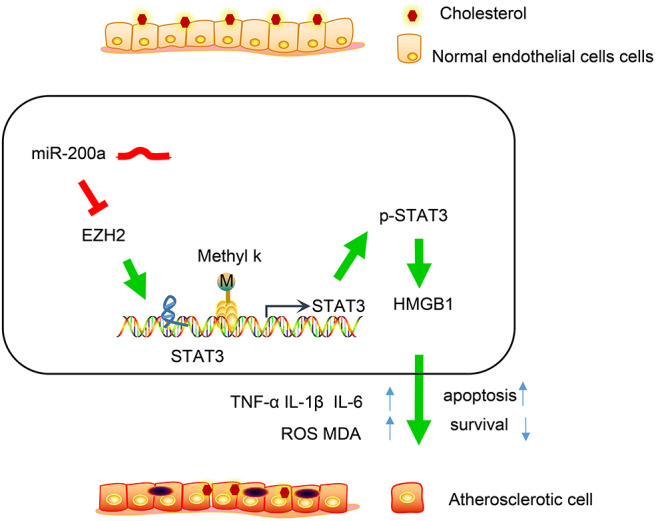
Schematic representation of the regulatory mechanism of miR-200a involvement in atherosclerosis. Overexpression of miR-200a inhibits EZH2 and HMGB1 expression by suppressing methylation and activation of STAT3 to inhibit cell injury, apoptosis, and inflammatory response, thereby repressing the progression of atherosclerosis.